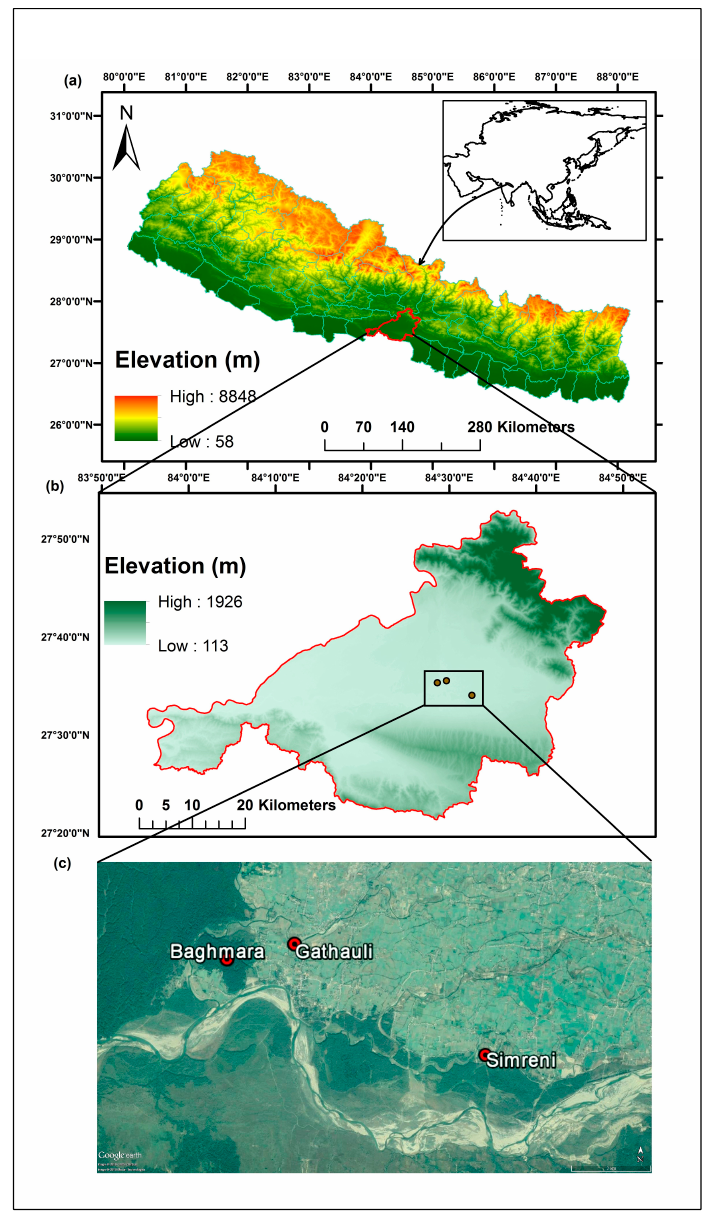
Figure 3. Figure showing ( a ) map of Nepal in the South Asia region, highlighting the study area in Chitwan district of Nepal; ( b ) enlarged map of Chitwan district showing the study area; and ( c ) Google Earth image showing study sites.